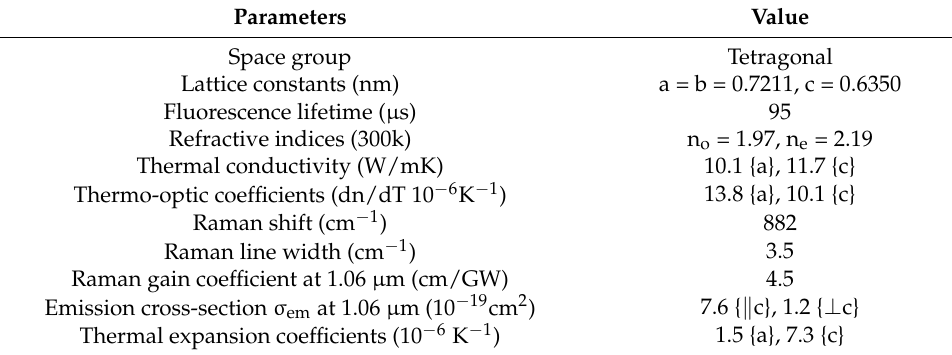
Table 3. Laser characteristic parameters of the Nd:GdVO 4 crystal [14,82].